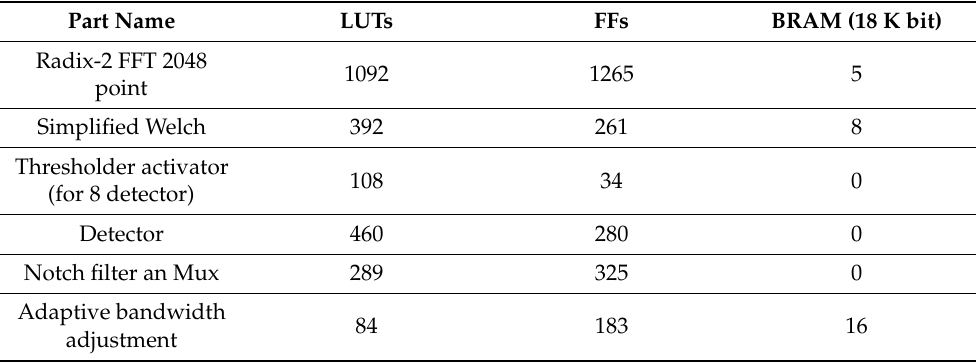
Table 4. Field-Programmable Gate Array (FPGA) resource for each part of the anti-interference